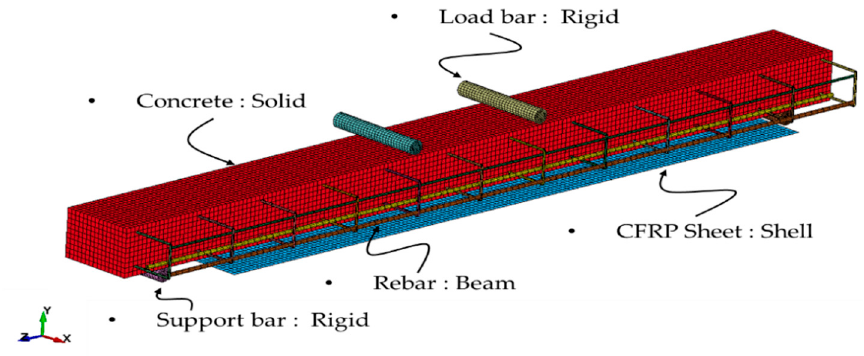
Figure 4. Finite element modeling.